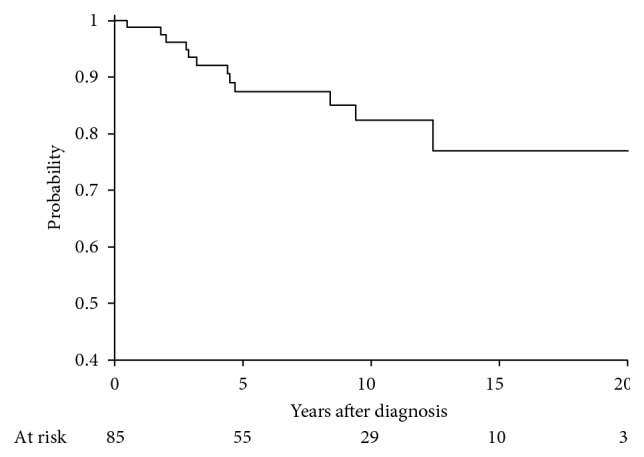
Overall survival at 5 years, 87.5% (77.2–93.3).